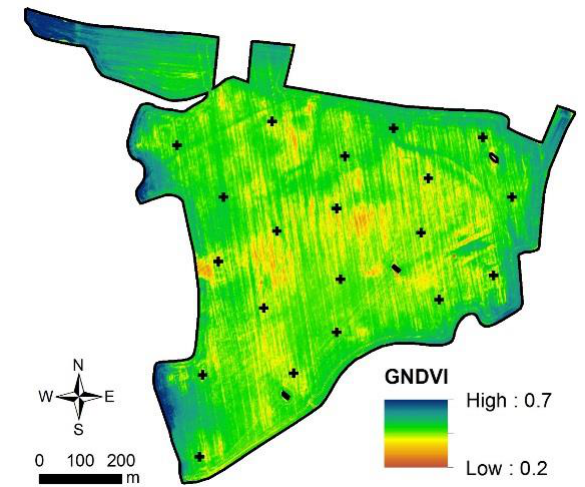
Figure 2. GNDVI image of the experimental field from UAV survey with the position of control points